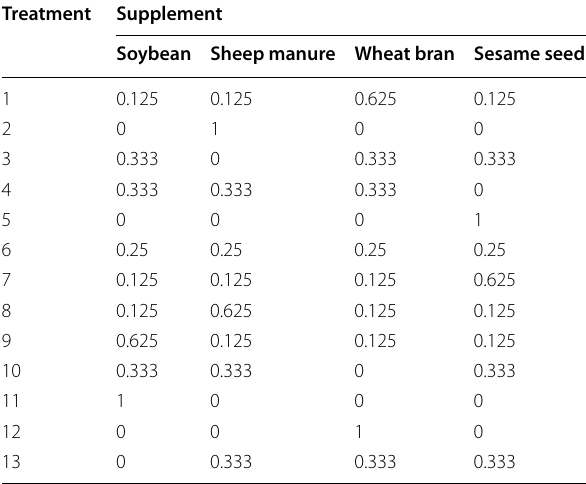
Table 1 Treatments used in the first supplementation trial (four ingredients) for the cultivation of A. bisporus on self- heated pasteurized Pangola grass Treatment